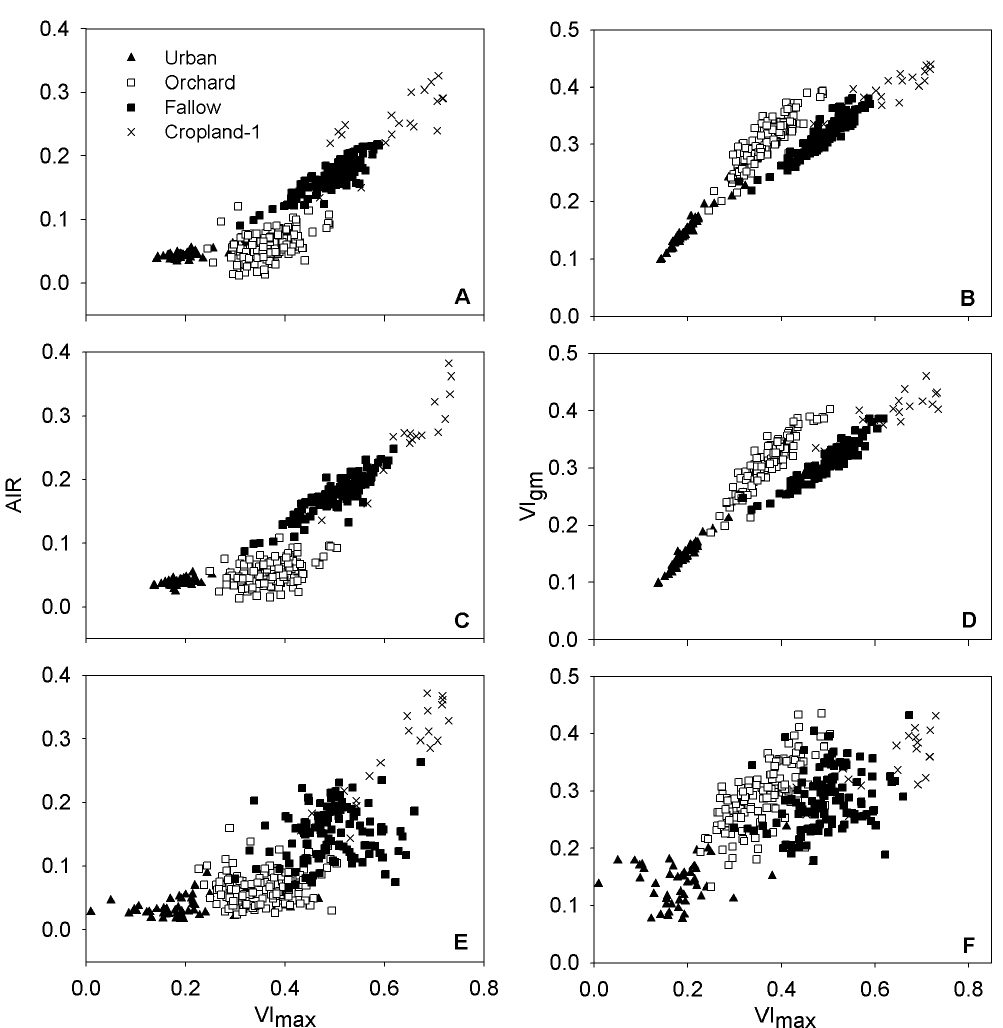
Figure 6. The cross-comparisons among parameters extracted. The left column represent the comparisons between AIR and VI max obtained via asymmetric Gaussian method (A), double logistic function (C), and Savitzky-Golay filter (E), respectively. The right column represent the comparisons of VI gm with VI max by using asymmetric Gaussian method (B), double logistic function (D), and Savitzky-Golay filter (F).